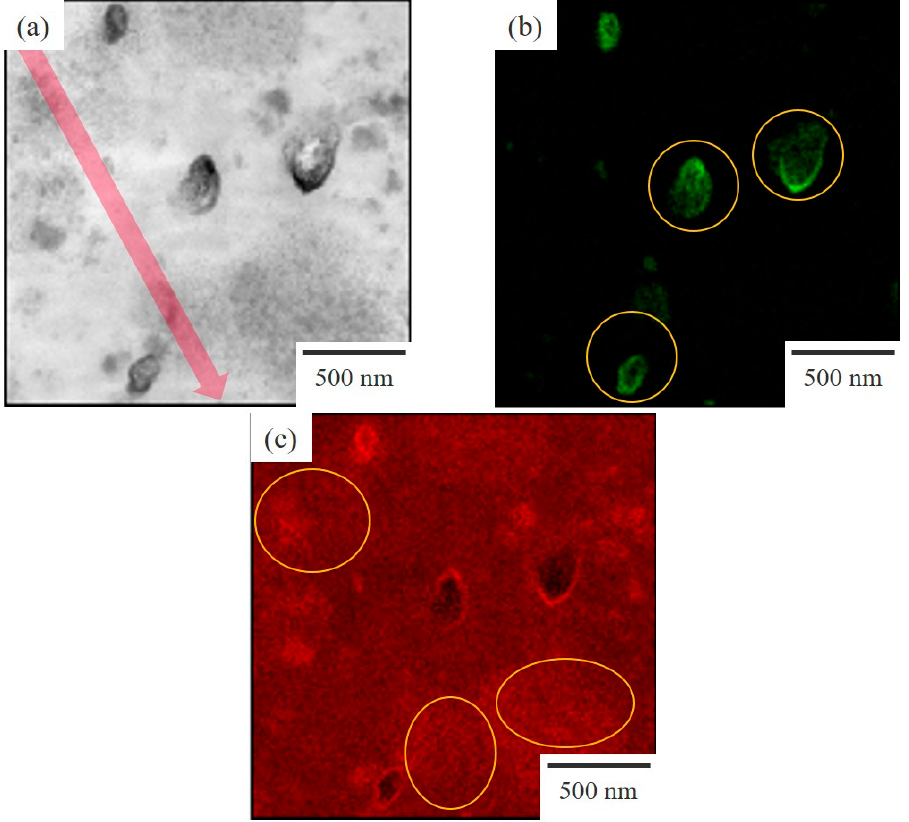
Figure 6. TEM micrographs of 60/40 NBR/PVC obtained by melt-mixing: ( a ) bright field TEM image; ( b ) EDS elemental mapping of zinc; ( c ) EDS elemental mapping of chlorine.